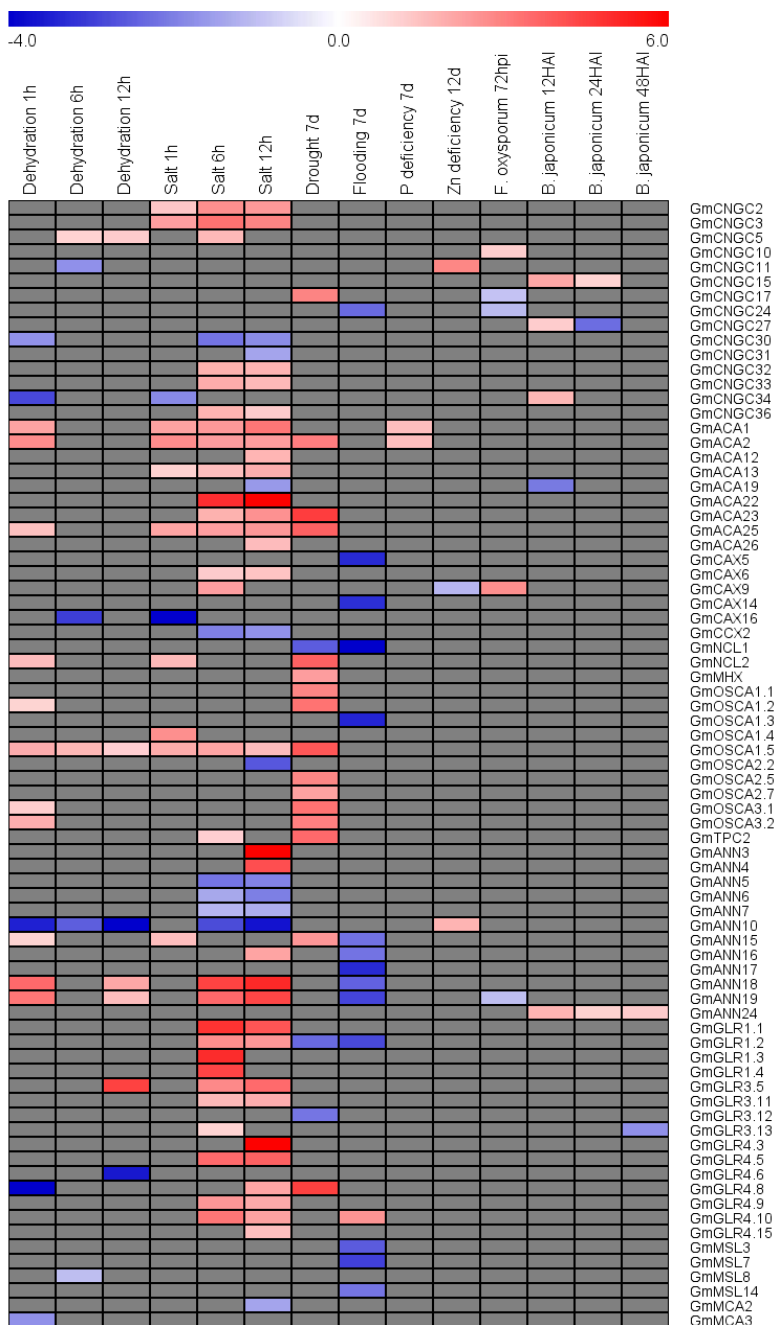
Figure 13. Heatmap representation for transcriptional responses of Ca 2+ transport genes under environmental stresses like salt in roots, dehydration in roots, flooding in leaves, drought in leaves, phosphorus deficiency in roots, zinc deficiency in roots, and inoculation of pathogenic isolates of Fusarium oxysporum (72 h post-inoculation, hpi) in roots, and inoculation of symbiotic soil bacteria Bradyrhizobium japonicum (12 – 48 h after inoculation, HAI) in root hairs. The intensities of the color represent the relative magnitude of fold changes in log2 values according to high-throughput sequencing data (Fold change ≥ 2, p -value < 0.05). The red color indicates induction, the blue color indicates repression, and the gray color means there is no significant expressional change.